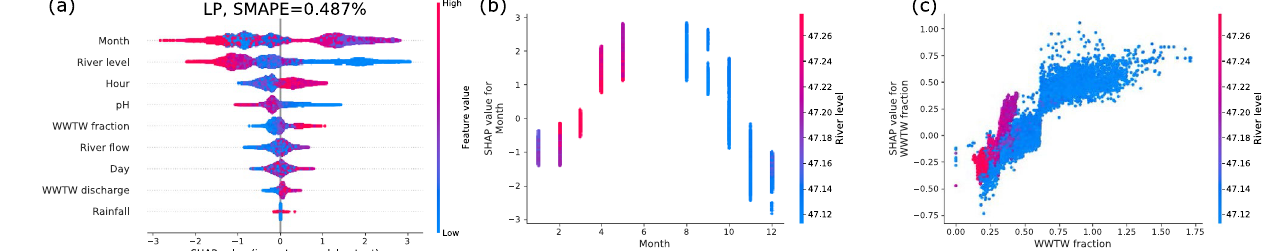
Figure 12. Temperature analysis of the LP site. We plot the feature ranking ( a ), the most important feature ( b ) and the dependency on the fraction of flow from the WWTW